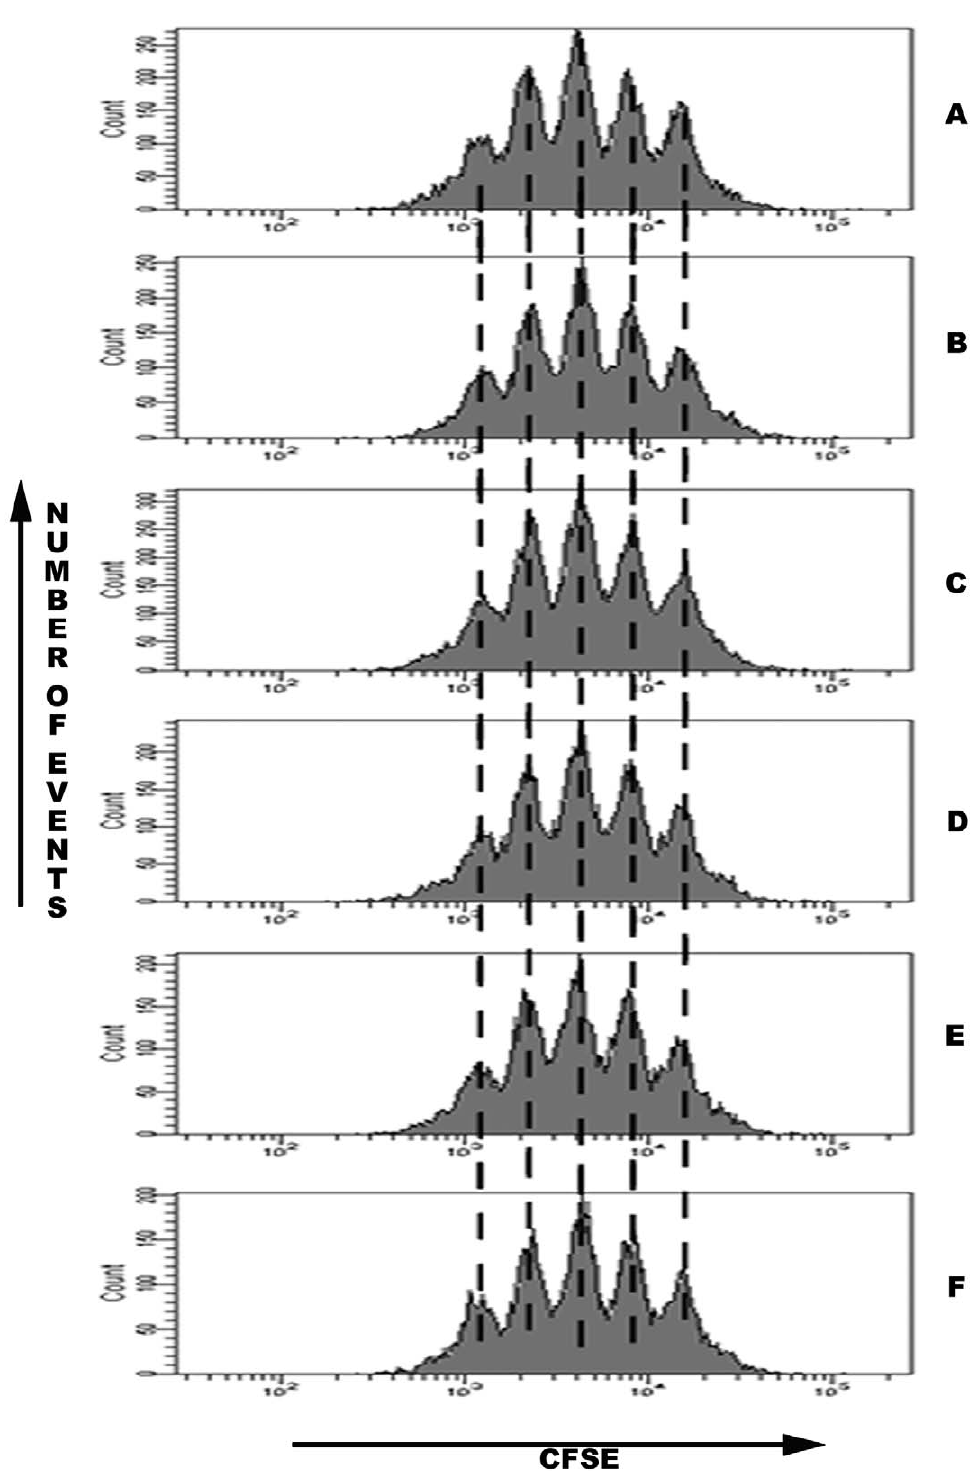
Figure 5. NGF does not influence NK cell proliferation. CFSE-stained splenocytes were cultured for three days in the presence of IL-2 and NGF at various concentrations; A: 0 pM (0 ng/ml), B: 0.1 pM (0.001 ng/ml), C: 1 pM, D: 3 pM, E: 10 pM (0.1 ng/ml), F: 10 4 pM (100 ng/ml). Then NK cells (CD3-NK1.1 + ) were analysed by flow cytometry. Every peak of CFSE fluorescence corresponds to one generation of cells. Data shown are from one representative experiment out of three performed.